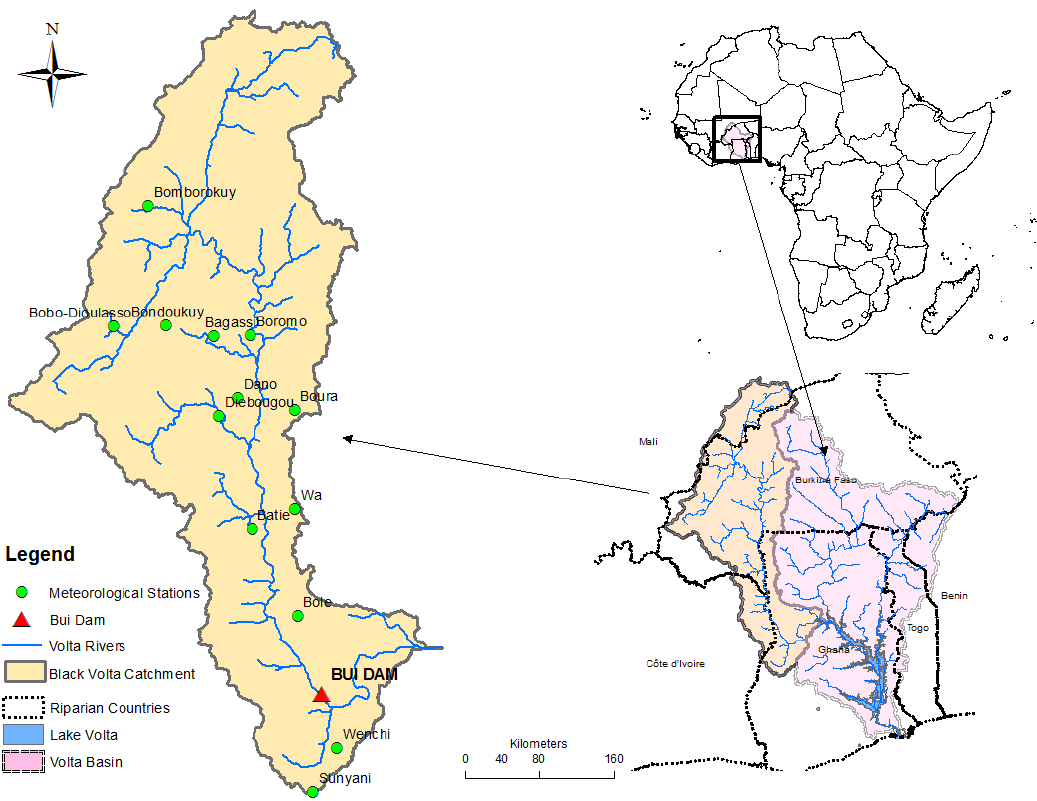
Figure 1. Study Area Presentation.